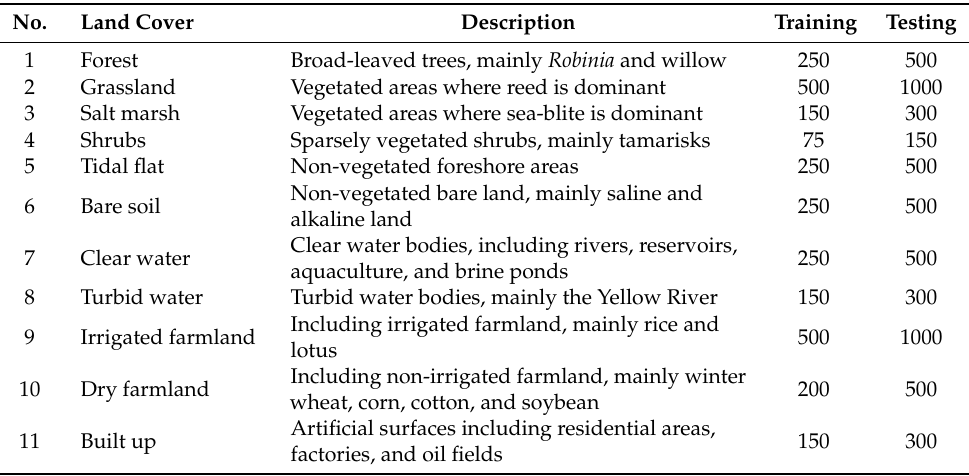
Table 1. Classification scheme of the Yellow River Delta.